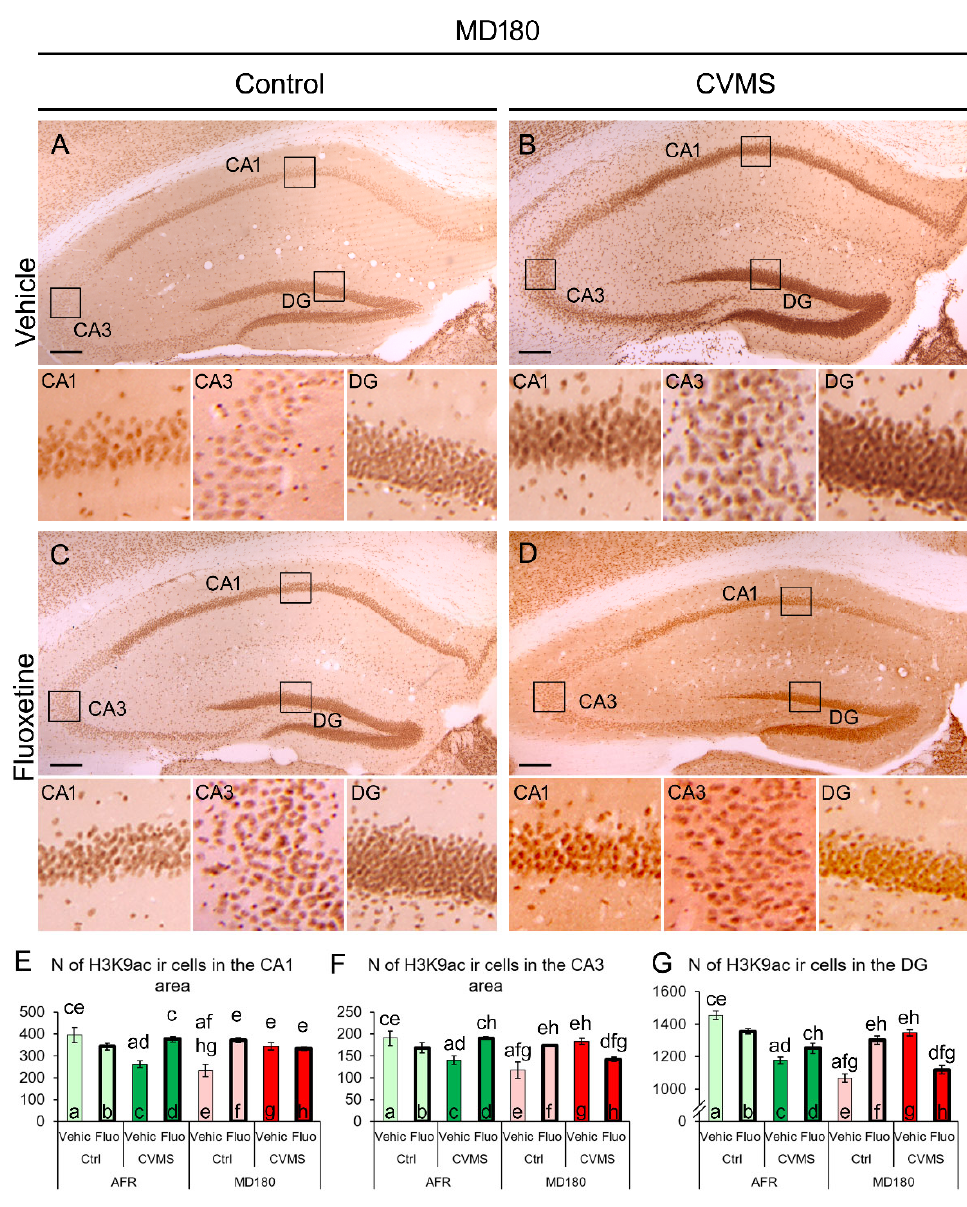
Figure 2. Acetyl-lysine 9 H3 histone (H3K9ac) immunoreactivity (ir) in the cornu ammonis (CA) 1, CA3, and dentate gyrus (DG) of the hippocampus. Representative images illustrate the H3K9ac-ir in vehicle (Vehic) ( A ) and fluoxetine (Fluo)-injected ( C ) control (Ctrl) and chronic variable mild stress (CVMS)-exposed vehicle ( B ) and fluoxetine-injected ( D ) mice with a history of maternal deprivation (MD180). Boxed areas are shown in higher magnification insets below the respective low magnification image. Histograms illustrate the dynamics of H3K9ac-ir in the CA1 ( E ), CA3 ( F ), and DG ( G ). Lettering indicates the most relevant significant differences between pairs of groups, according to the post hoc tests (n = 4–6). AFR: animal facility rearing. Bars: 200 µ